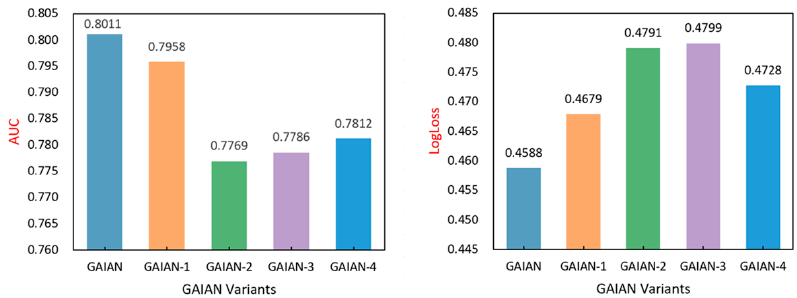
Figure 4. The performance of different variants of GAIAN on the Criteo dataset.